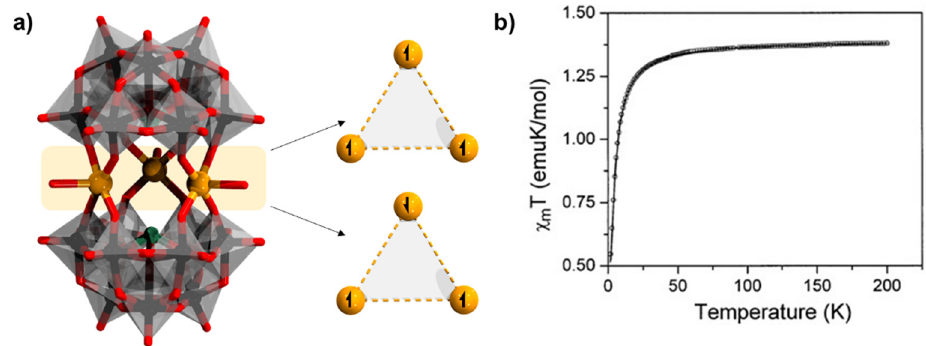
Figure 6. ( a ) Representation of [(Cu(H 2 O)) 3 ( α -SbW 9 O 33 ) 2 ] 12 − and depiction of the two spins triangles as ground and excited states on the three Cu II sandwiched heterometals; ( b ) representative magnetic susceptibility plot ( χ m T vs. T at H = 1000) for {(Cu(H 2 O)) 3 ( α -XW 9 O 33 ) 2 } (X = As, Sb, Se, and Te) reproduced with permission from reference [68] published by Wiley. Color code: X = green (but covered), M = brown, {WO 6 } = gray octahedra, W = black, and O = red. Hydrogen atoms from aqua ligands are omitted.